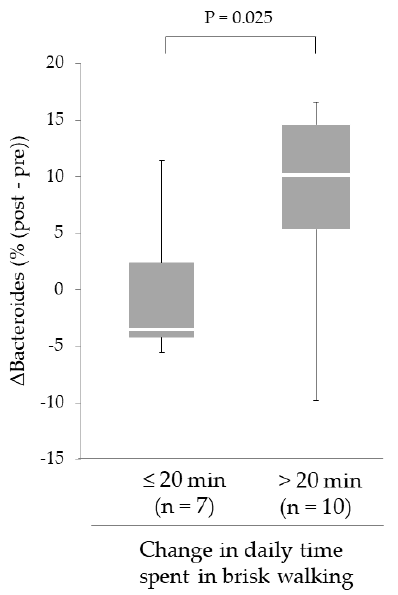
Figure 5. Effect of increased daily physical activity on changes in the relative abundance of intestinal Bacteroides following the intervention in the AE group. Increases in intestinal Bacteroides in subjects who increased the daily time spent in brisk walking for 20 min. or more were greater than in those who did not (by the Mann–Whitney U-test). Horizontal bars indicate the minimum values, the 25th, 50th, 75th percentile levels, and the maximum values. Abbreviations: AE, aerobic exercise training.